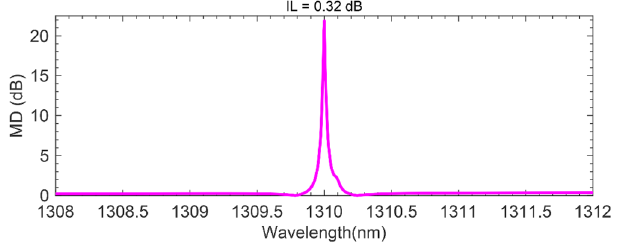
Figure 6. MD ( λ ) and IL at λ = 1310